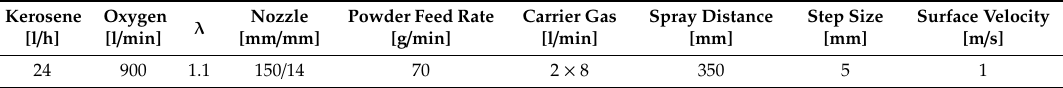
Table 1. Setting parameter of AISI 316L coatings for the HVOF K2